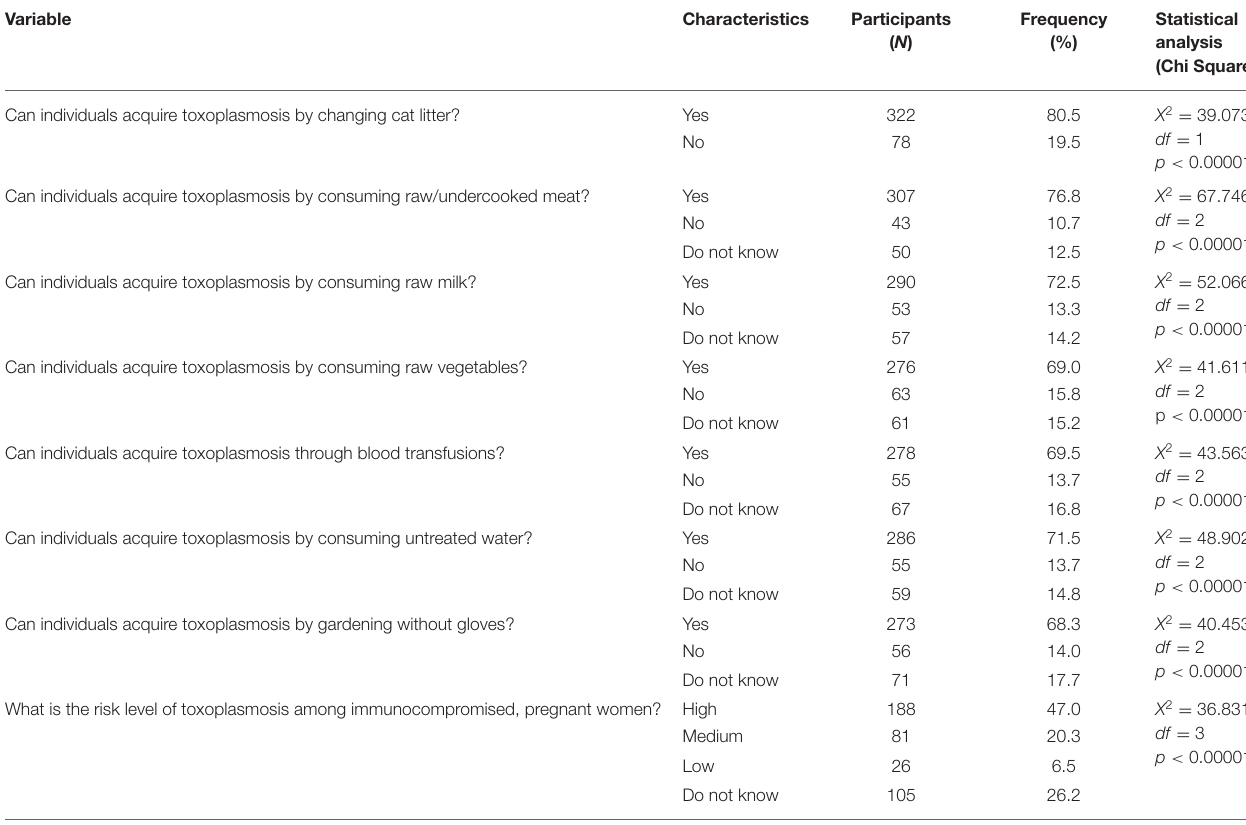
TABLE 5 | Risk factors of toxoplasmosis. Variable Characteristics Participants